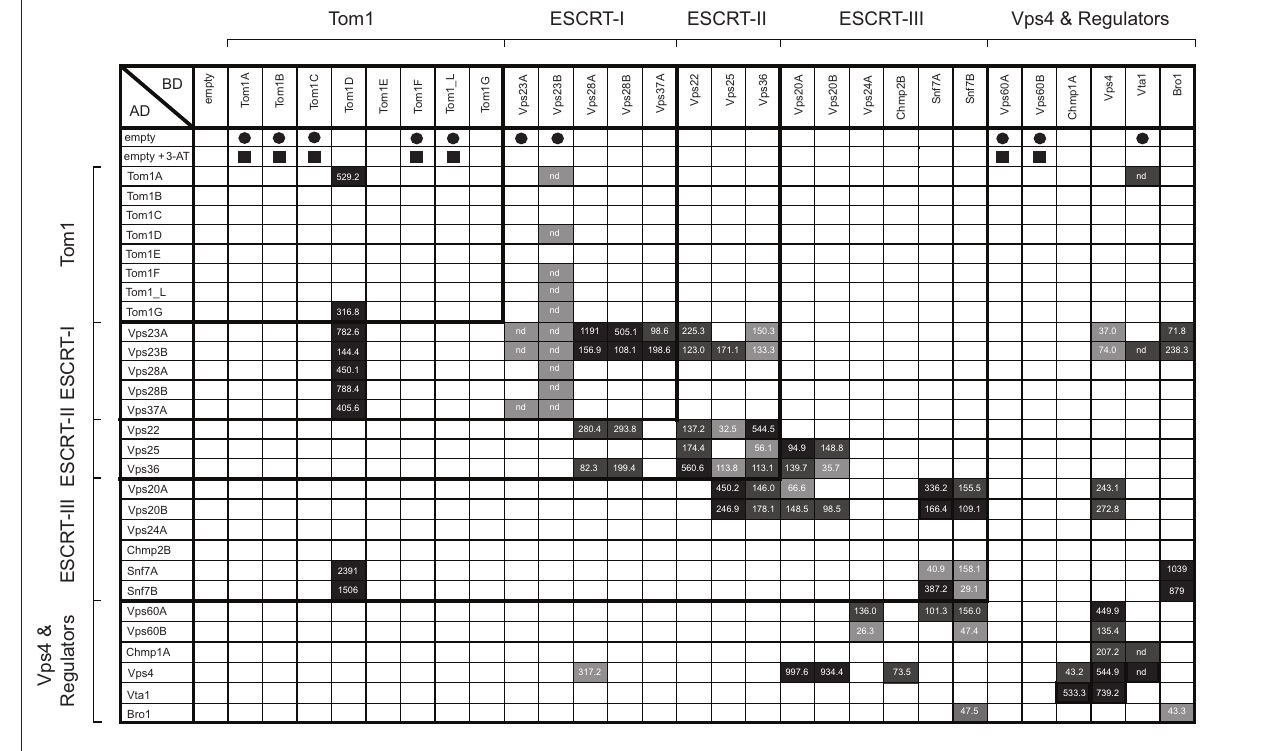
relative rates of yeast growth on high‑stringency selection media (with 3‑AT) as either: strong (black), medium (dark gray), weak (light gray), or no growth (white). Also indicated in the matrix are the averages of the measured β ‑Gal activities for each positive‑interacting protein pair, with the exception of those interactions in which yeast strains that harbored certain BD‑ESCRT plasmids along with the “empty” AD plasmid displayed growth (autoactivation) on low‑selection media alone (indicated as “nd”). Note that the relative growth rates of most yeast strains expressing a positive‑interacting protein pair are generally proportional to their calculated β